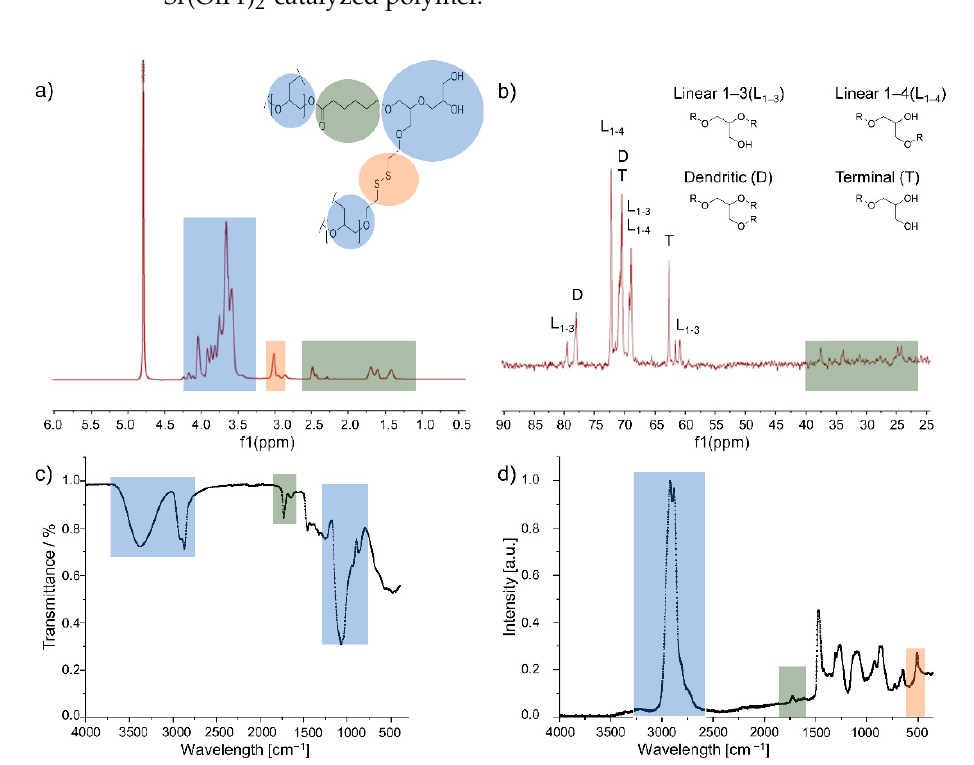
Figure 2. Analysis of the synthesized copolymers with color-coded structural units of glycidol (blue), SSG (red) and ε -CL (grey). ( a ) 1 H NMR spectrum with assignment of specific peaks of the three different monomer species; ( b ) inverse gated 13 C NMR spectrum with assignment of the signals of linear, dendritic and terminal carbon signals for the calculation of the degree of branching; ( c ) IR spectrum; ( d ) Raman spectrum.